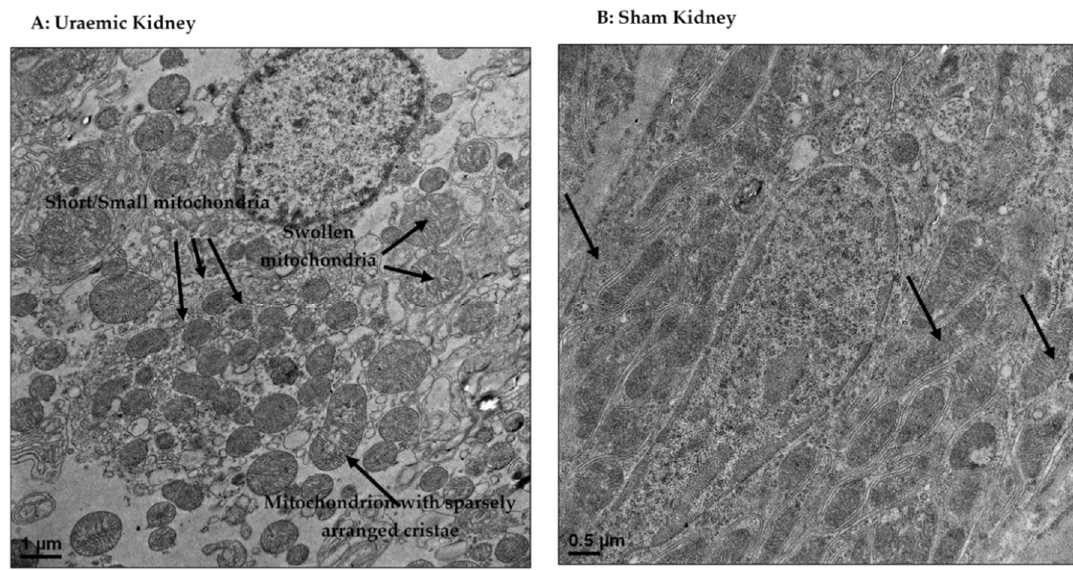
Figure 9. Transmission electron microscopic representation of uraemic mitochondria ( A ) with evidence of mitochondrial fragmentation (fission) as indicated by the presence of smaller mitochondrial spheres; swollen mitochondria with sparsely arranged cristae relative to sham mitochondria ( B ). Arrows indicate mitochondria.